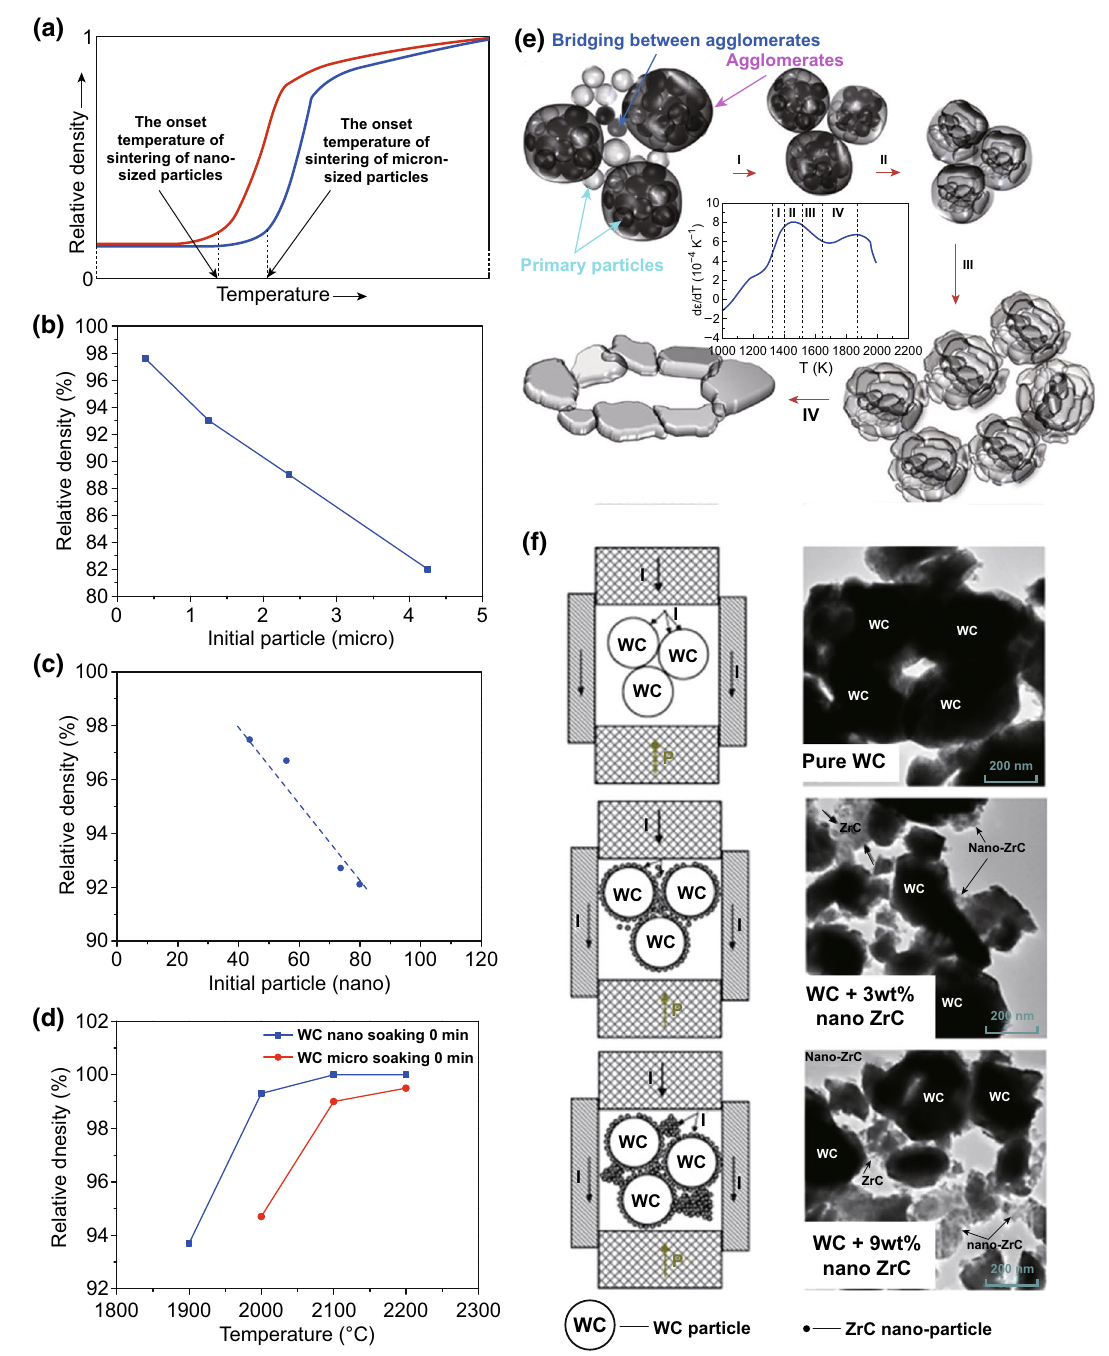
Fig. 3 a Schematic diagram illustrating different onset temperatures of sintering of nano‑ and micro‑sized particles [44]. Relative density of pure WC as a function of initial particle size in BTC b microsize [56] and c nanosize [57]. d Relative density of micro and nano WC versus sin‑ tering temperature, without holding time [40]. e Schematic of the sintering mechanism of nano WC on the basis of the experimental shrinkage strain rate in a non‑isothermal experiment [48]. f Schematic diagrams and corresponding TEM micrographs revealing the contact state of WC and ZrC nano‑particles during sintering [63]. Figure panels reproduced from Ref. [44] with permission from Taylor & Francis copyright 2008, Ref. [56] with permission from Elsevier copyright 2004, Ref. [57] with permission from Elsevier copyright 2017, Ref. [40] with permission from Elsevier copyright 2008, Ref. [48] with permission from Elsevier copyright 2011, Ref. [63] with permission from Elsevier copyright